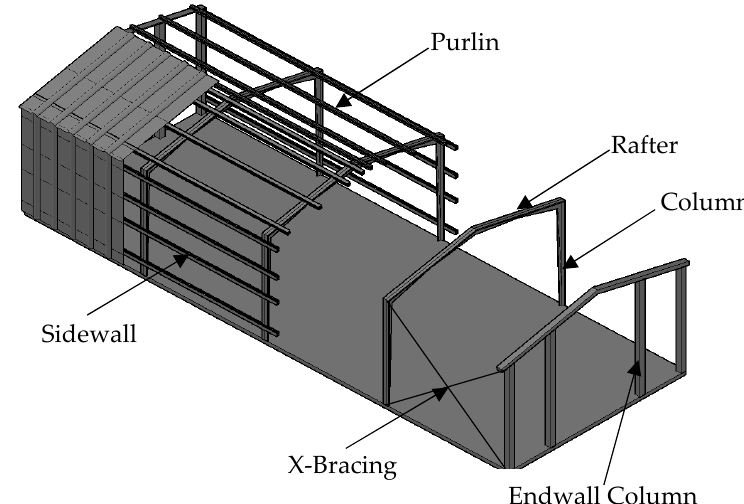
Figure 1. Steel-gabled frames.